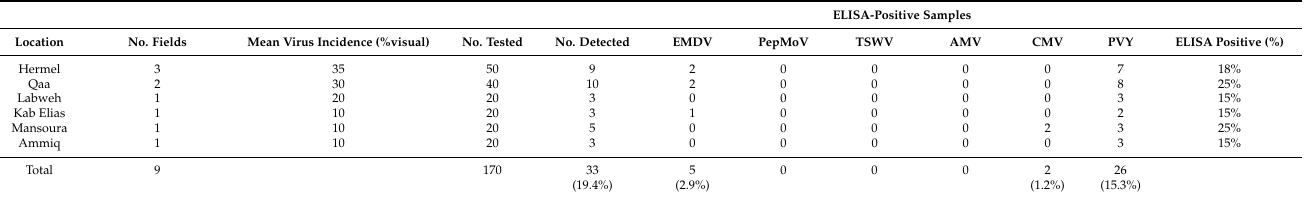
Table 2. Prevalence of virus infections revealed by visual inspection and ELISA tests in eggplants plants collected from north, center and western areas of Bekaa valley.